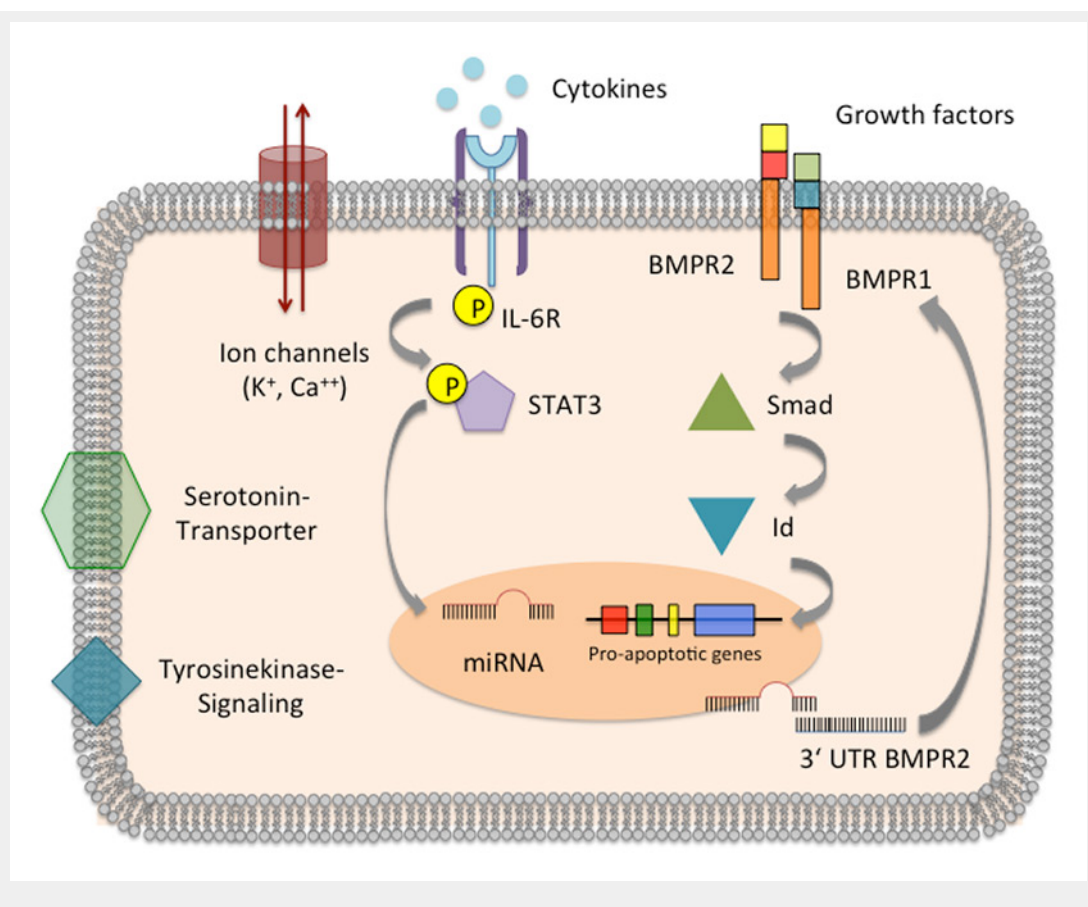
Figure 3 Overview of important factors in pulmonary vascular remodelling . BMPR2 is expressed on pulmonary artery smooth muscle cells and is the master regulator in remodelling of pulmonary arteries. Upon binding of ligands, BMPR2 and BMPR1 dimerise and activate proapoptotic genes through the action of the transcription factors Smad and Id (inhibitor of differentiation). Dysregulation of this pathway, for example due to mutations in BMPR2 , results in a proproliferative state. Inflammatory cytokines (e.g. interleukin-6 [IL-6]) phosphorylate the transcription factor STAT3 and induce the expression of miRNAs. MicroRNAs act as gene silencers and downregulate BMPR2, which directly inhibits cell cycle regulators. Ion channels, serotonin transporters and receptors associated with tyrosine kinase signalling are also involved in mediating vasoconstriction and